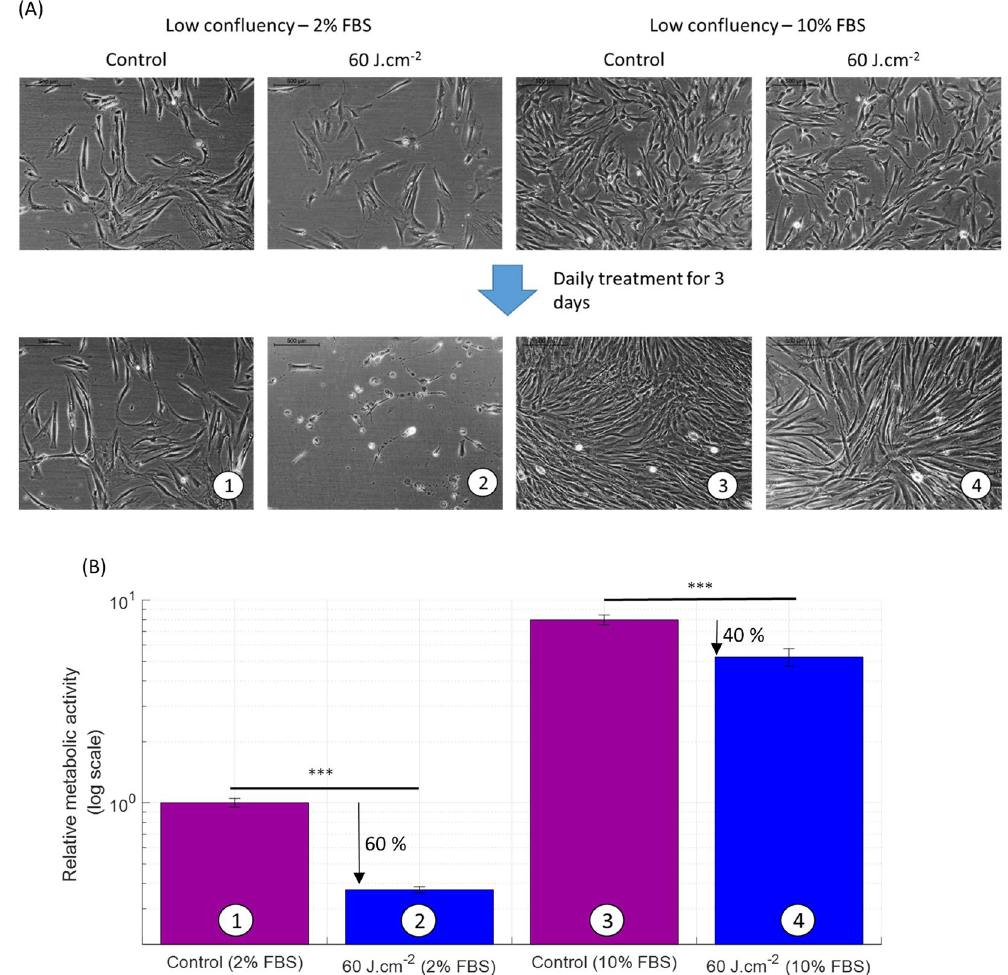
Figure 3. Serum concentration in the culture medium reduces the inhibitory effect of blue light (450 nm) on the metabolic activity of human dermal fibroblasts. ( A ) Phase-contrast images of human reticular fibroblasts on day 0 (8 days after seeding) at low initial confluency and cultured in DMEM with two serum concentrations 2% and 10% (upper line), and after three daily light treatments on day 4 at a low initial confluency (lower line). Papillary fibroblasts were found to behave similarly (not shown). A second donor responded similarly (not shown). ( B ) Relative metabolic activity of human reticular fibroblasts after light treatment at 450 nm, 50 mW. cm − 2 with 60 J.cm − 2 (log scale). We observe a 60% reduction in 2% FBS against 40% reduction in 10% FBS case compared to control. The high confluency level showed similar variation as a function of the change in FBS concentration (not shown), except for the cytotoxic effects observed in low serum/low confluency only. Statistical significance was evaluated using ANOVA. A second donor responded similarly (not shown as the scale is absolute). The control group has an average relative metabolic activity of 1. (N = 2, 2 lineages and 3